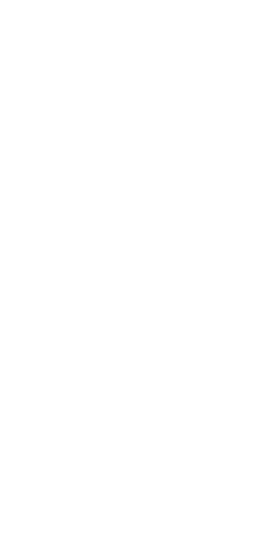
Table 9. Adsorption capacities of fluoride by different types of rice straw (adopted from